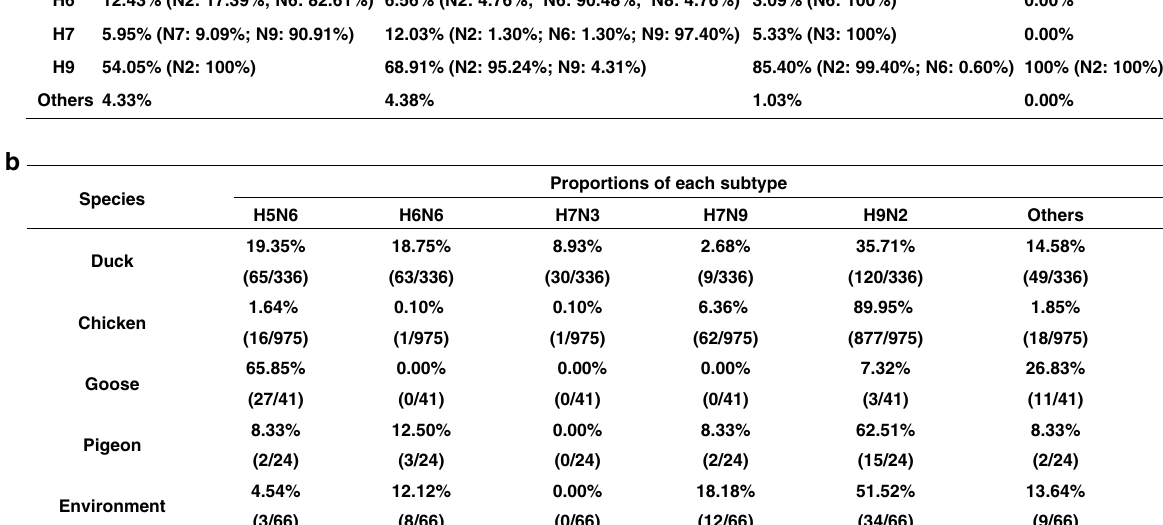
Fig. 2 Virus subtype proportions and host species distributions of the pure isolates with a single HxNy subtype. a The proportion of various HA subtypes of pure isolates with a single HxNy subtype isolated between 2016 and 2019. The major prevalent subtypes include H5, H6, H7, and H9. H5 viruses include H5N6 and H5N8; H6 viruses include H6N2, H6N6, and H6N8; H7 viruses include H7N2, H7N3, H7N6, H7N7, and H7N9; H9 viruses include H9N2, H9N6, and H9N9. b Host species distributions of H5N6, H6N6, H7N3, H7N9, H9N2, and other subtypes. Source data are provided as a Source Data fi